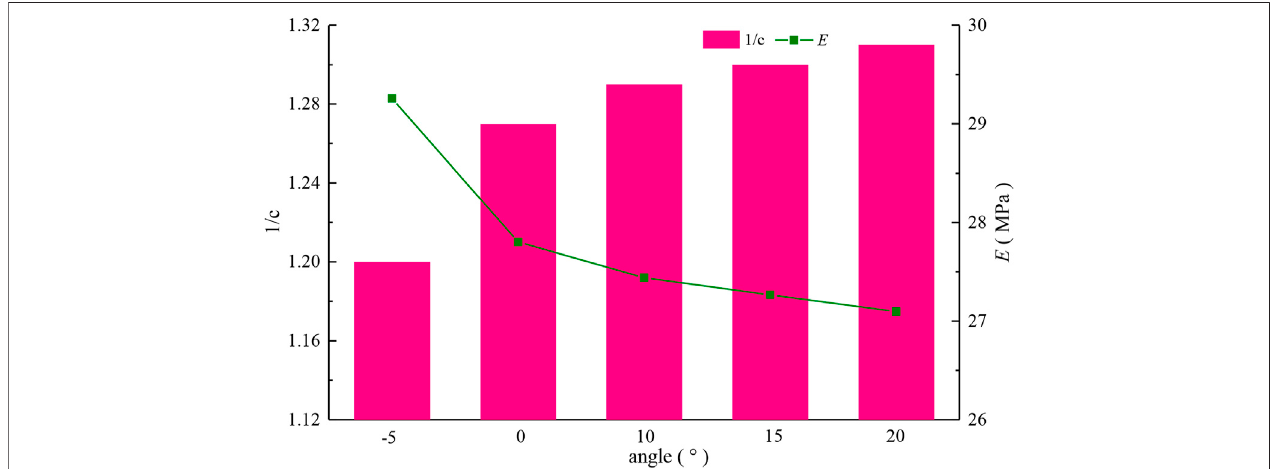
FIGURE 8 | Distribution of the mass ratio of mining and back fi lling with the change of inclination angle.